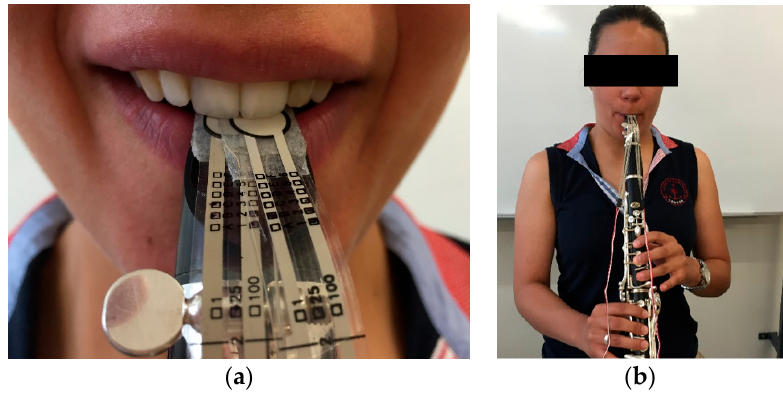
Figure 8. ( a ) Verifying the adaptation of the piezoresistive sensors on the musician’s mouthpiece; ( b ) Clarinet player performing different pitches whilst recording the pressure applied at the upper central incisors.